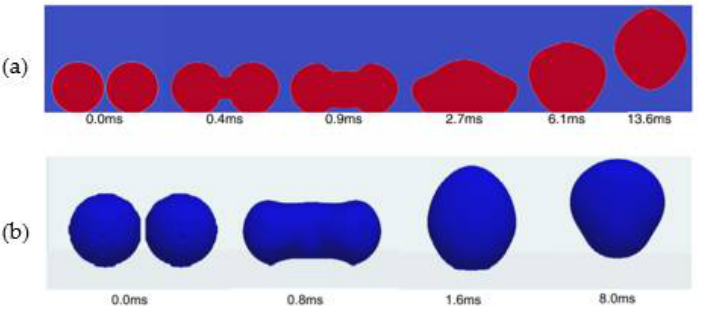
Figure 26. The droplets coalescence and jumping phenomena on the superhydrophobic surface. ( a ) 2D lattice Boltzmann method. ( b ) 3D volume of fluid method. Reprinted with permission from Ref